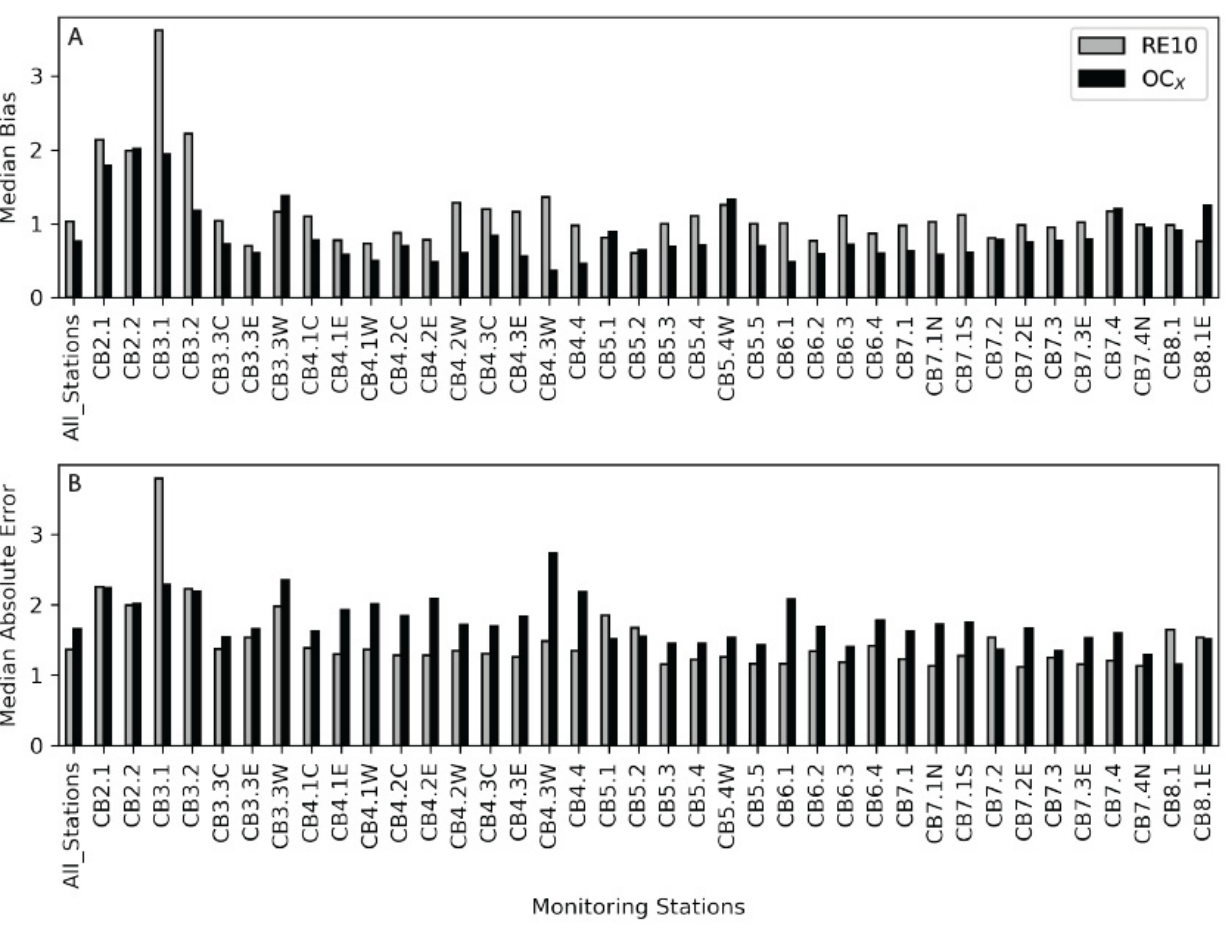
Figure 5. ( A ) Median bias from the field data and the OLCI-RE10 (gray) and the OLCI-OC4 (black) imagery for each station from the Chesapeake Bay Program. The stations run from left to right and represent a transect from the head of the bay to the mouth of the bay (Figure 1). Values closer to 1 indicate less bias. ( B ) The Median Absolute Error (MedAE) is presented in the same fashion as the median bias.